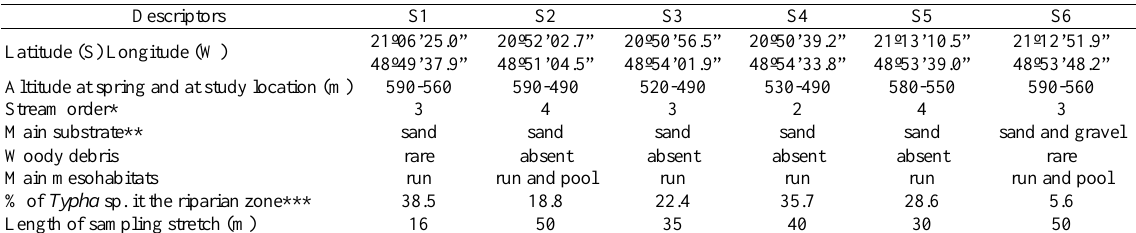
Table 1. Location and environmental descriptors of six stream stretches sampled in the upper rio Turvo basin, southeastern Brazil. * Strahler’s convention (1:50.000 scale), ** visually categorized according to Cummnis’ scale as cited by Hynes (2001), *** considering 30 m width of each margin at each studied